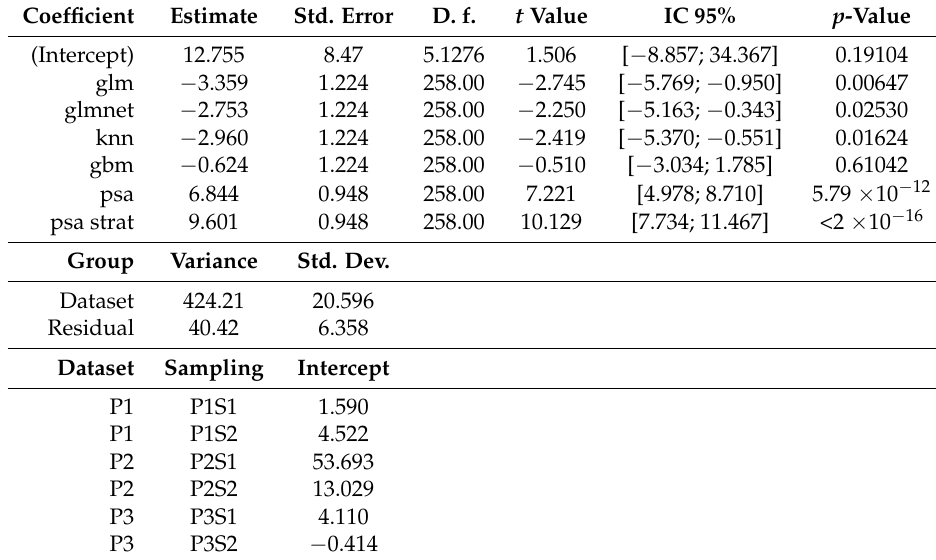
Table 2. Linear mixed-effects model on the modulus of relative bias ( | RBias | ) considering adjustment methods and algorithms as fixed effects and datasets as random effects. Reference levels: Bagged Trees ( treebag ) algorithm and matching adjustment.